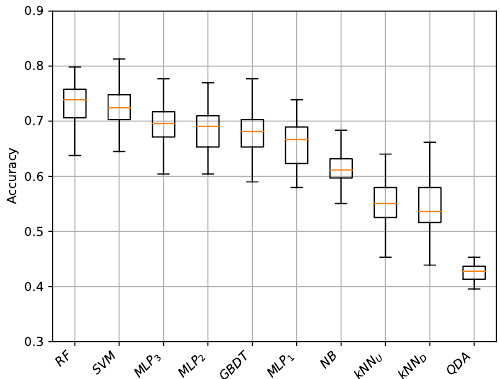
Figure 3. Box-plots for the accuracy scores obtained in the experiment that considers all the